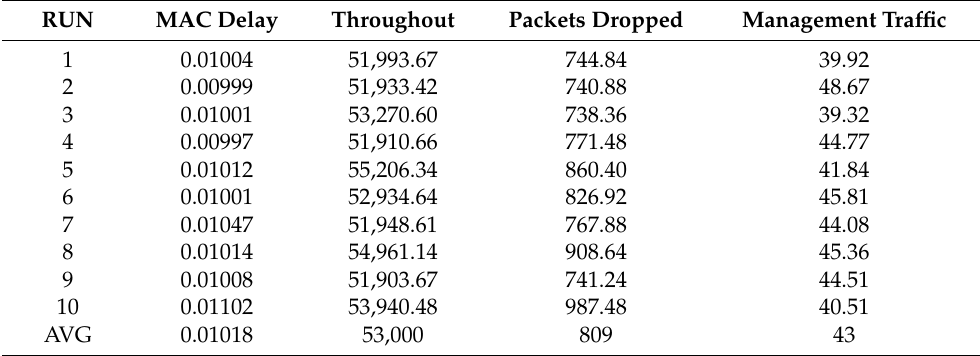
Table 16. Fire Station Scenario ZigBee